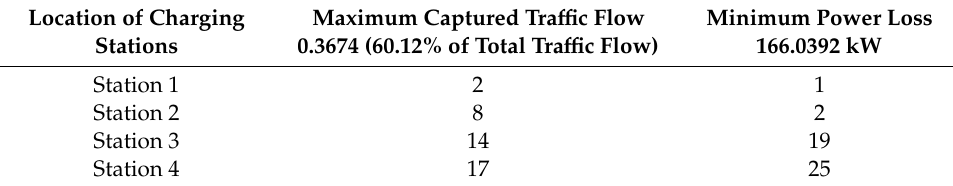
Table 4. Result of the